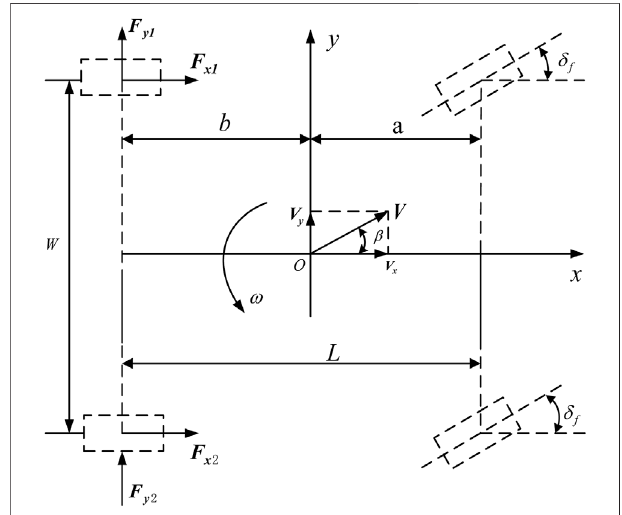
FIGURE 2 | Five-degrees-of-freedom vehicle